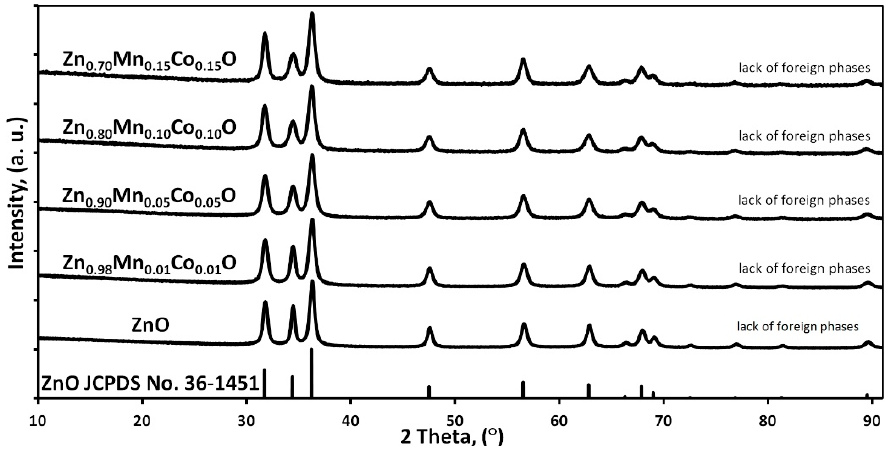
Figure 4. XRD diffraction patterns of Zn (1 − x − y) Mn x Co y O NPs (where x = y), with the nominal content of dopants in the solution being 0, 1, 5, 10, 15 mol %.